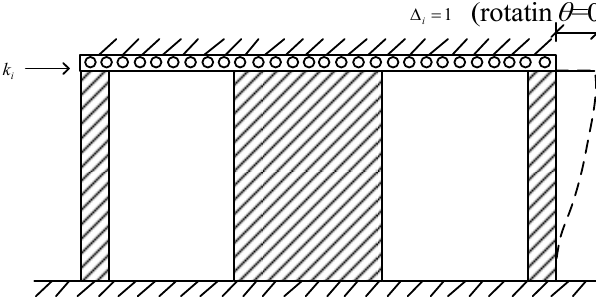
Figure 6: Calculation model of the new and old high guage’s lateral